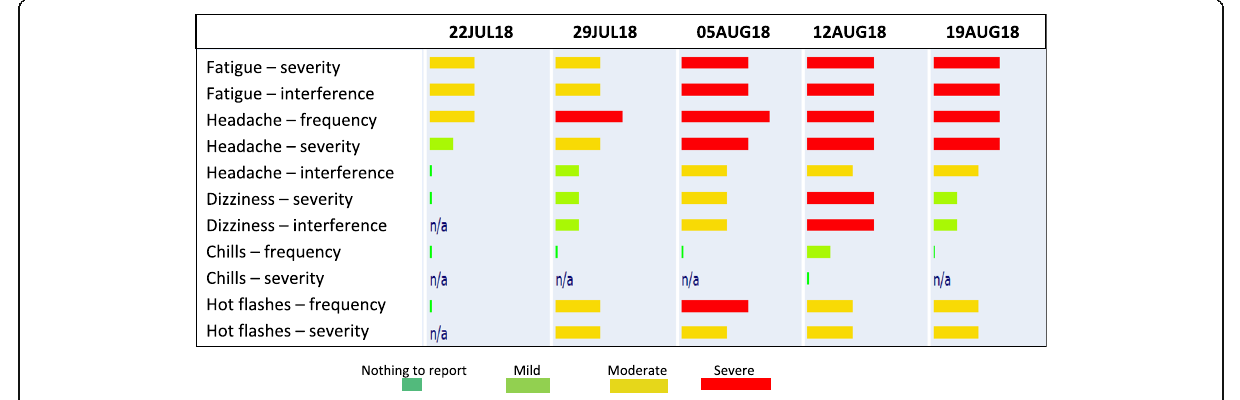
Fig. 1 Example of patient reporting available to